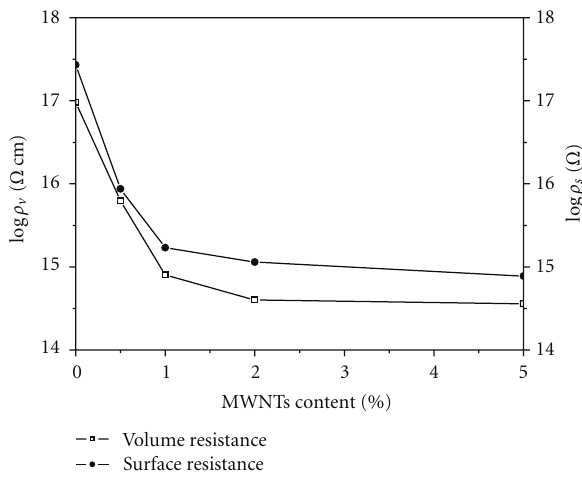
Figure 4: The influence of MWNTS OH on the electrical properties of